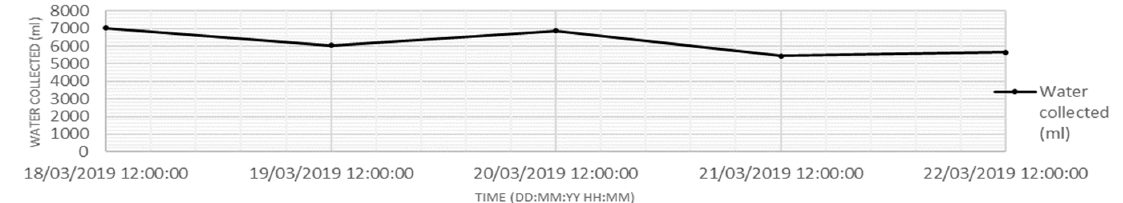
Figure 20. The total amount of water collected by SS and HDH in the third week.